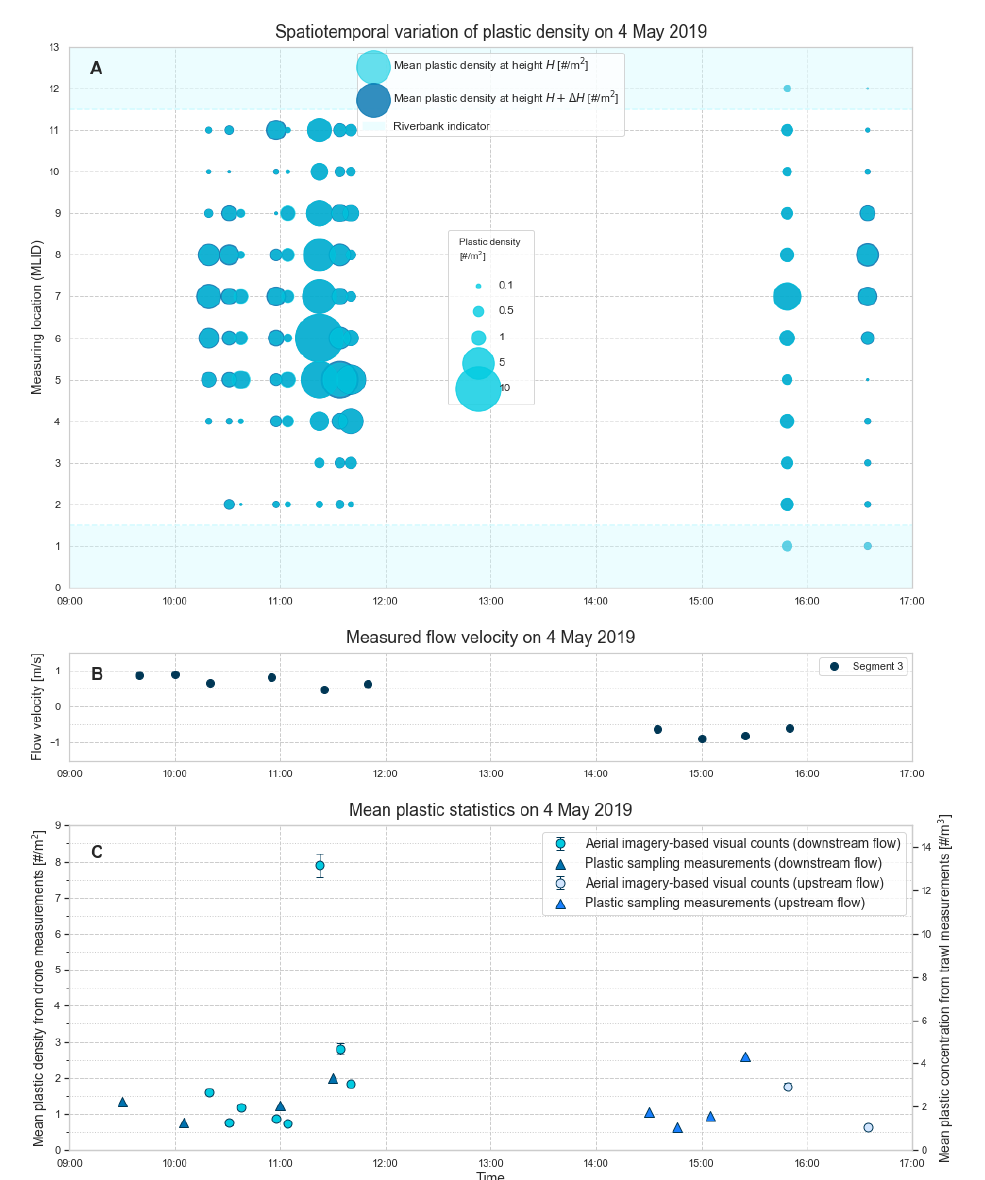
Figure 7. Overview of measured plastic statistics. ( A ) Spatiotemporal variation of the plastic density on 4 May 2019. The mean plastic density without taking into account the possible error introduced by the altitude difference ∆ H , and the plastic density calculated for the case that the maximum recorded altitude difference ∆ H is introduced everywhere during flight are indicated. The shown densities are absolute, i.e., not taking into account the flow direction of the river. ( B ) The recorded flow velocity obtained by visual measurements for all individual segments at the Jalan Tengku Kalana bridge on 4 May 2019. Negative values indicate an upstream current. ( C ) Overview of the mean plastic density in #/m 2 from drone measurements averaged over the width of the bridge, set out against the total plastic concentration in #/m 3 as measured by plastic